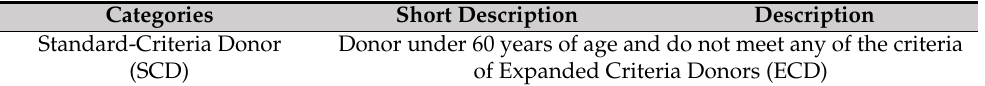
Table 1. Criteria for deceased kidney donors: SCDs, ECDs and DCDs.